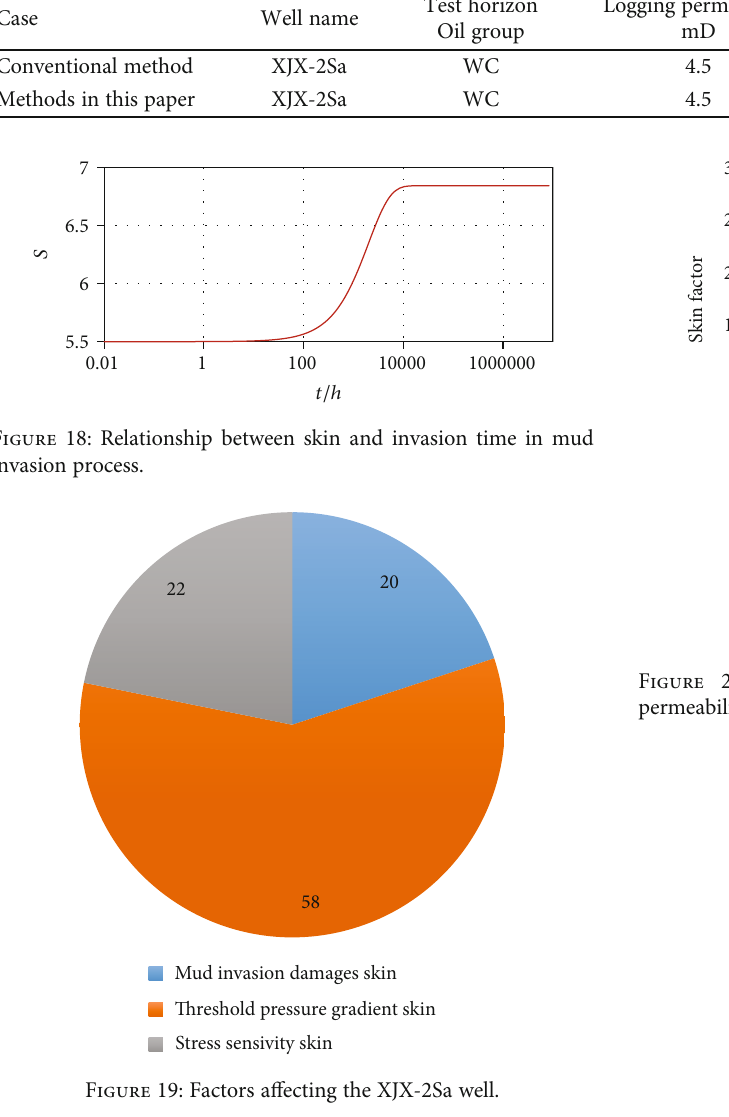
Figure 21: Factors a ff ecting the XJX-2Sa